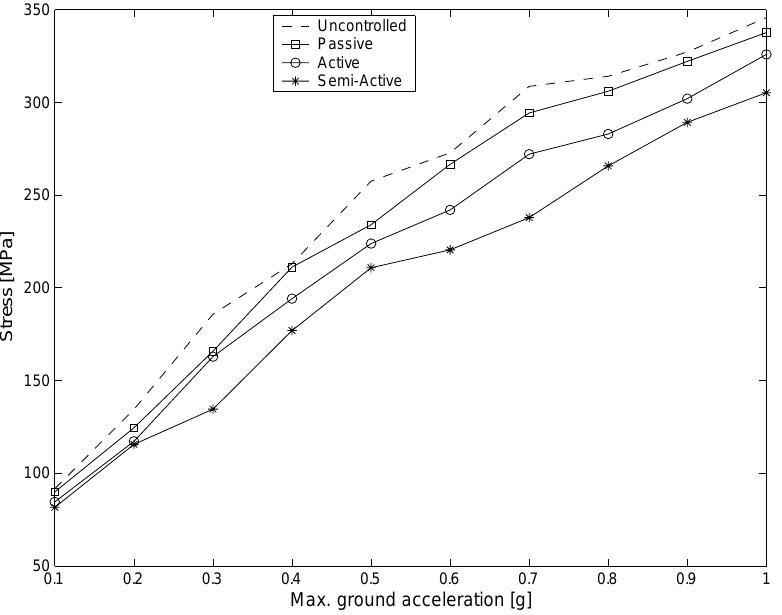
Fig. 7. Mean-plus-one-standard-deviation of the maximum stress in the rails for passive, active and semi-active devices with 10% mass ratio damper for an ensemble of synthetic ground